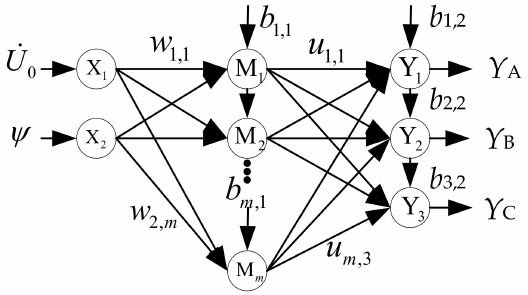
Figure 3. Phase selection of stator ground fault based on BP neural